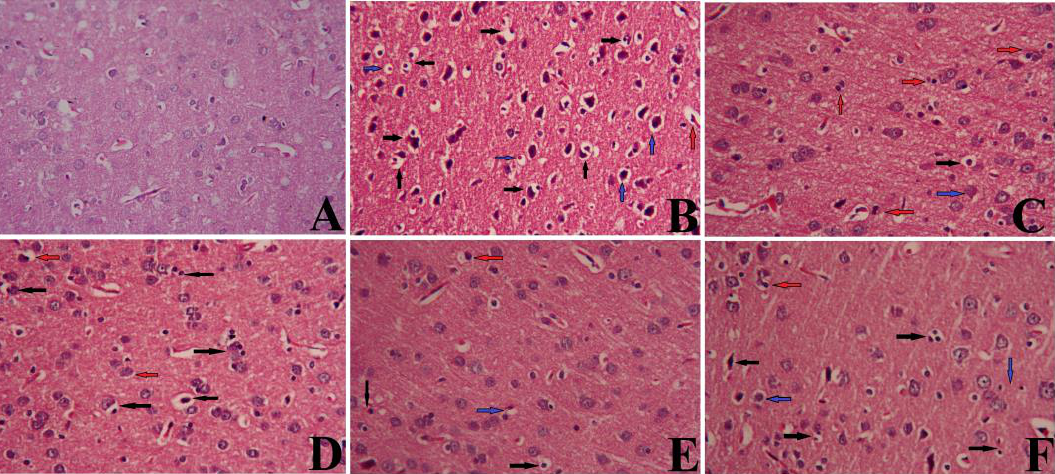
Figure 8. Effects of oral administration of Syzygium aromaticum extract (SAE), sodium selenite (Na 2 SeO 3 ), and green synthetized SeNPs using SAE (SAE-SeNPs) on histopathology of cortical tissue following pentylenetetrazole (PTZ)-induced epileptic seizures ( n = 8). ( A ): control group; ( B ): PTZ-treated group; ( C ): SAE + PTZ-treated group; ( D ): Na 2 SeO 3 + PTZ-treated group; ( E ): SAE-SeNPs + PTZ-treated group; and ( F ): diazepam + PTZ-treated group. Scale bar = 80 µm. Black arrows indicate apoptotic neurons, blue arrows indicate vacuolated neurons, and red arrows indicate inflammatory cells infiltration.